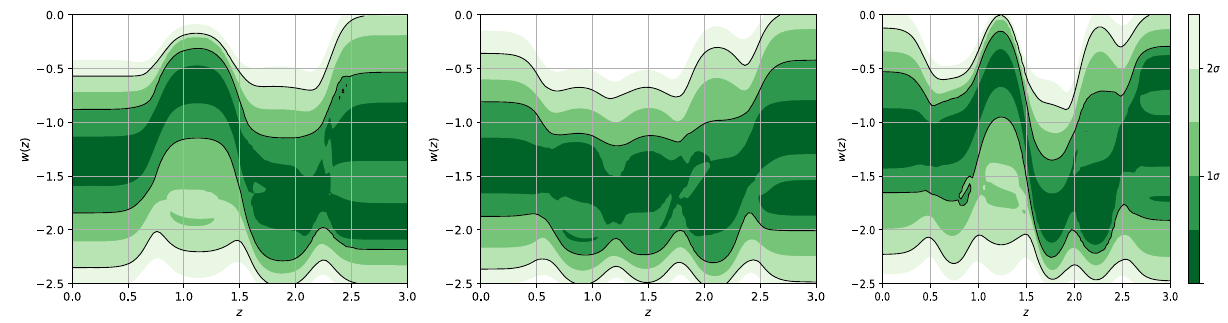
Fig. 9 Functional posteriors of the EoS reconstruction, from up to down, with 4, 5 and 6 bins using only Hubble parameter data